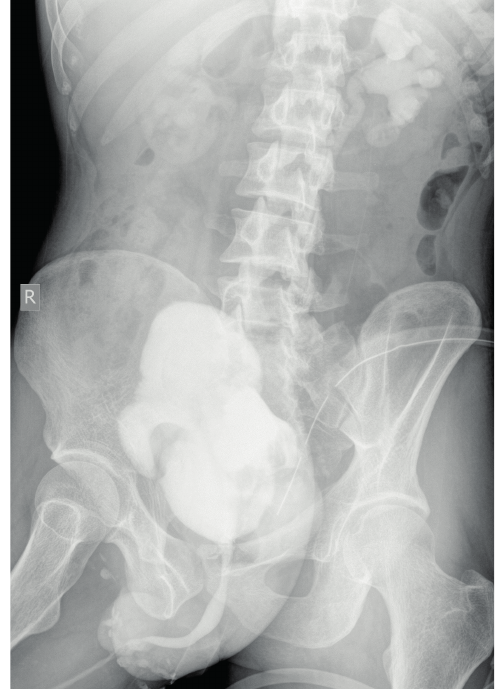
figure 5 - postoperative McU showing a good capacity neobladder with no extravasation. The urethra appears normal. There is reflux of contrast on both